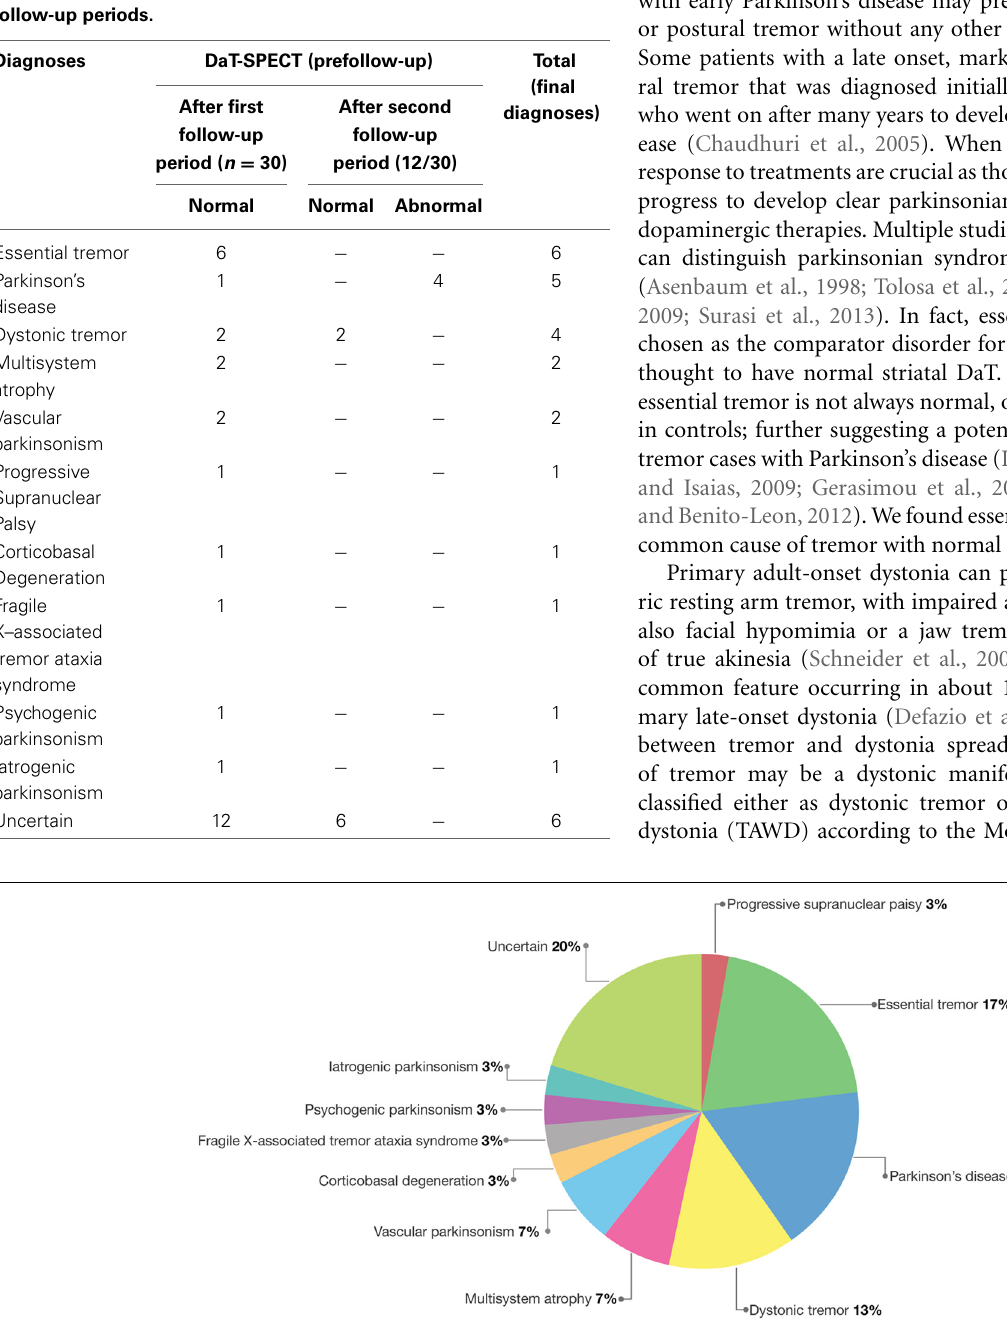
FIGURE 3 | Pie graph showing the distribution of final diagnoses and relative